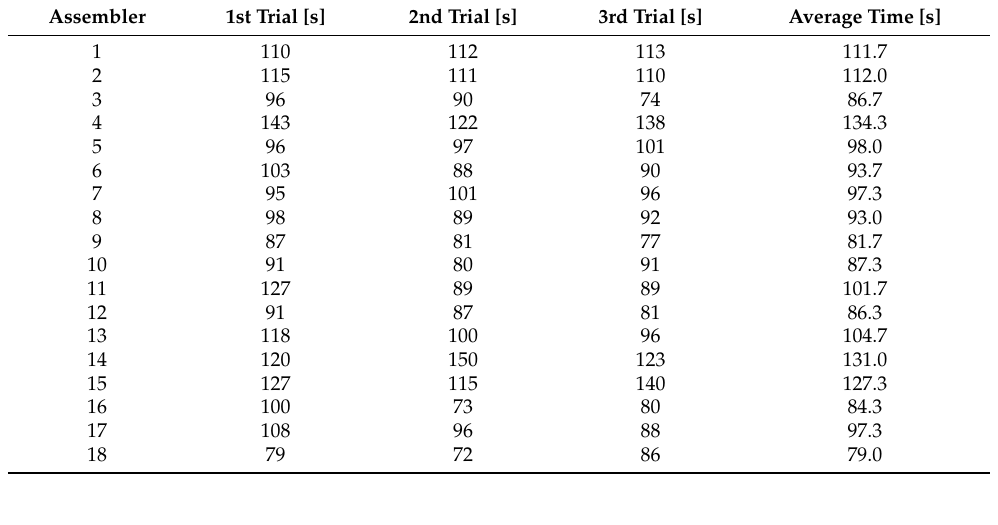
Table 5. Assembly time using guided instructions without PTL modules.